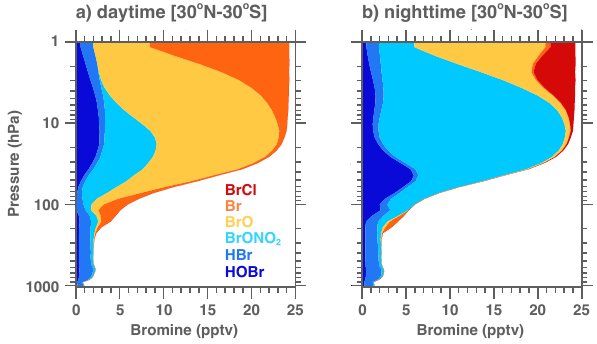
Figure 4. Annual mean model inorganic bromine (BrCl, Br, BrO, BrONO 2 , HBr, HOBr) tropical vertical profiles for daytime (left panel) and nighttime (right panel), averaged between 30 ◦ N and 30 ◦